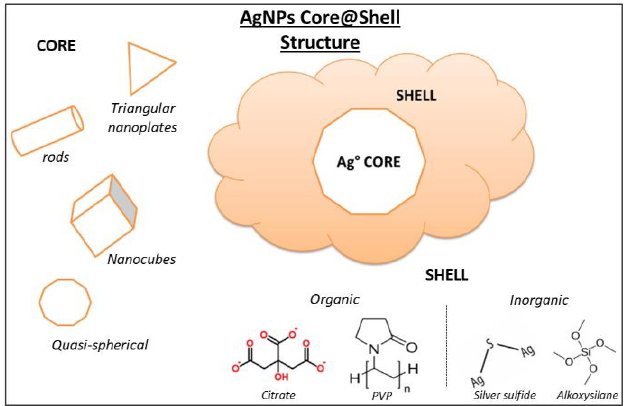
Figure 8. Silver nanoparticles core@shell structure. Adapted from [114]. Copyright (2012), American Chemical Society.